Question: Condense the content of this figure into a single sentence.
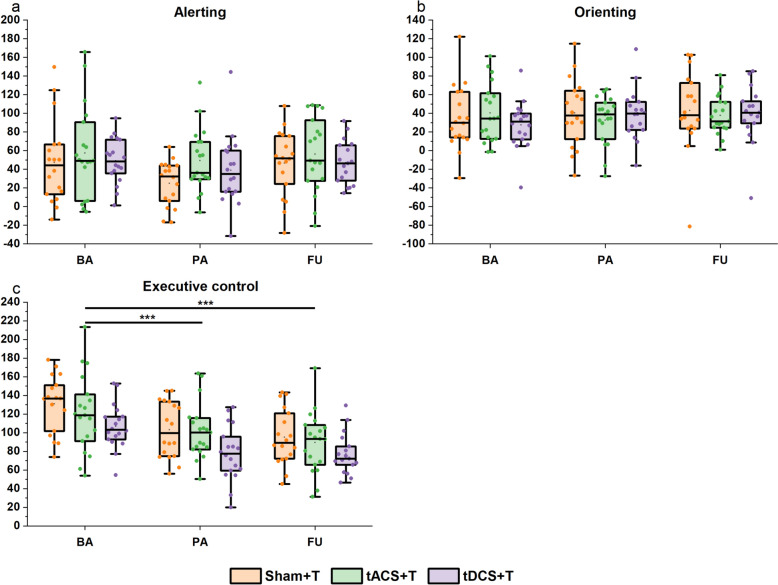
Answer: Performance of the three attentional networks. Data are presented as boxplots with overlaid individual participant data points for each group (Sham + T, tACS + T, tDCS + T). The box represents the interquartile range (IQR), the horizontal line indicates the median, and whiskers denote the data range. BA = baseline; PA = post-assessment; FU = follow-up. Panels a–c correspond to the Alerting, Orienting, and Executive control networks, respectively. For the Executive control network, lower scores indicate better efficiency. *: 0.01 < p ≤ 0.05; **: 0.001 < p ≤ 0.01; ***: p ≤ 0.001